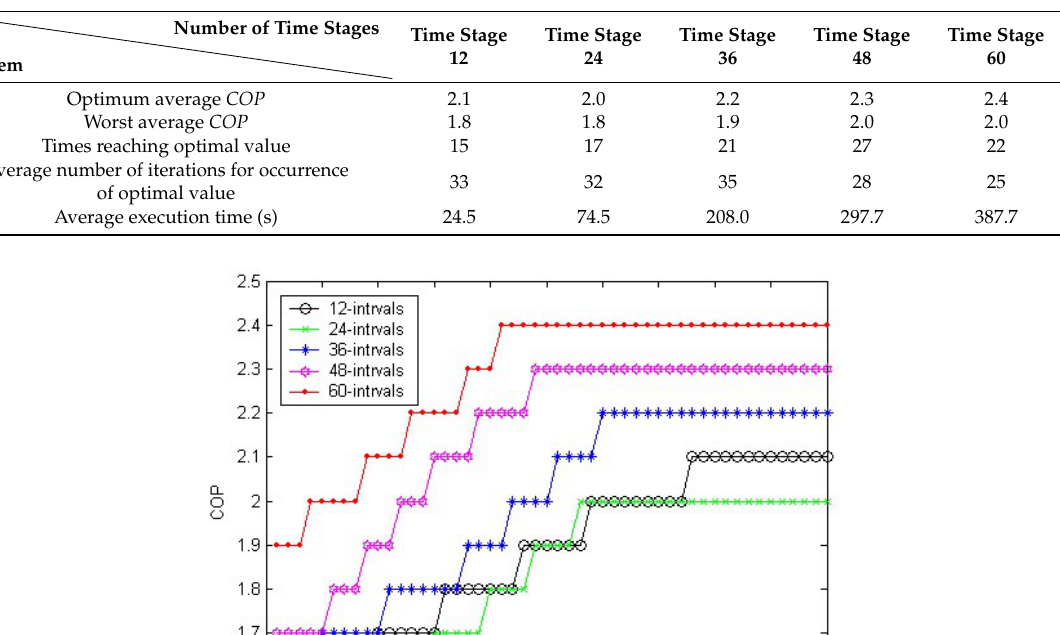
Table 7. BPA test for different numbers of time stages.